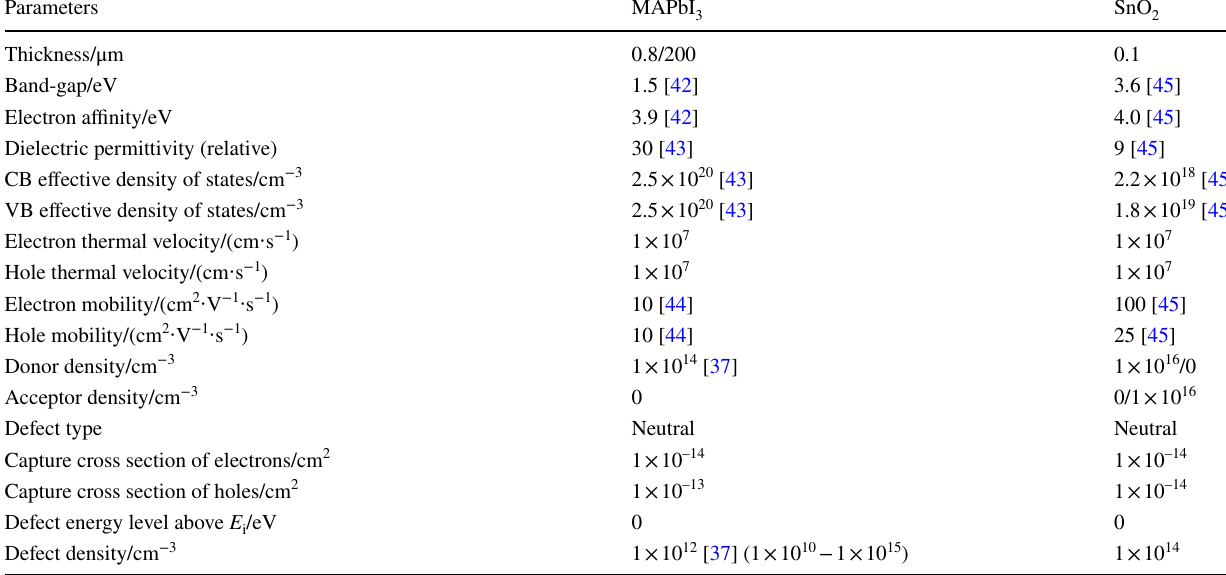
Table 2 Details of basic parameters used for the simulation of MAPbI